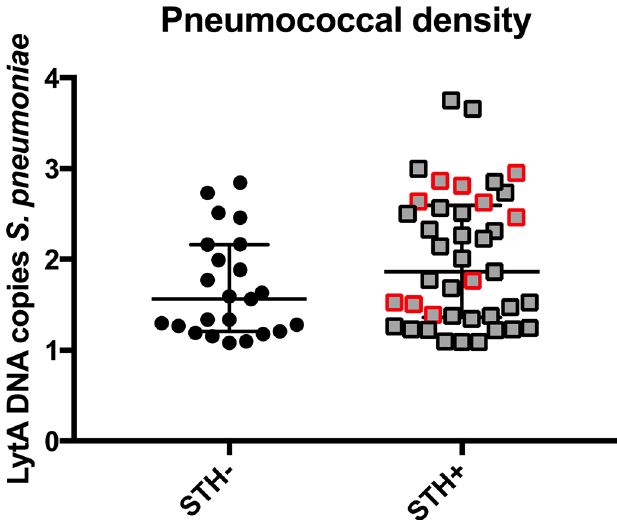
Figure 2. Pneumococcal carriage density in STH-uninfected versus STH-infected children. lytA PCR was performed on oropharyngeal swabs collected as part of the ECUAVIDA cohort study in order to determine pneumococcal carriage density in STH-uninfected (STH-) and STH-infected (STH +) respectively. STH + includes T. trichiura, A. lumbricoides and mixed T. trichiura/A. lumbricoides infections combined. Red outline indicates A. lumbricoides infections alone. Median and IQR are